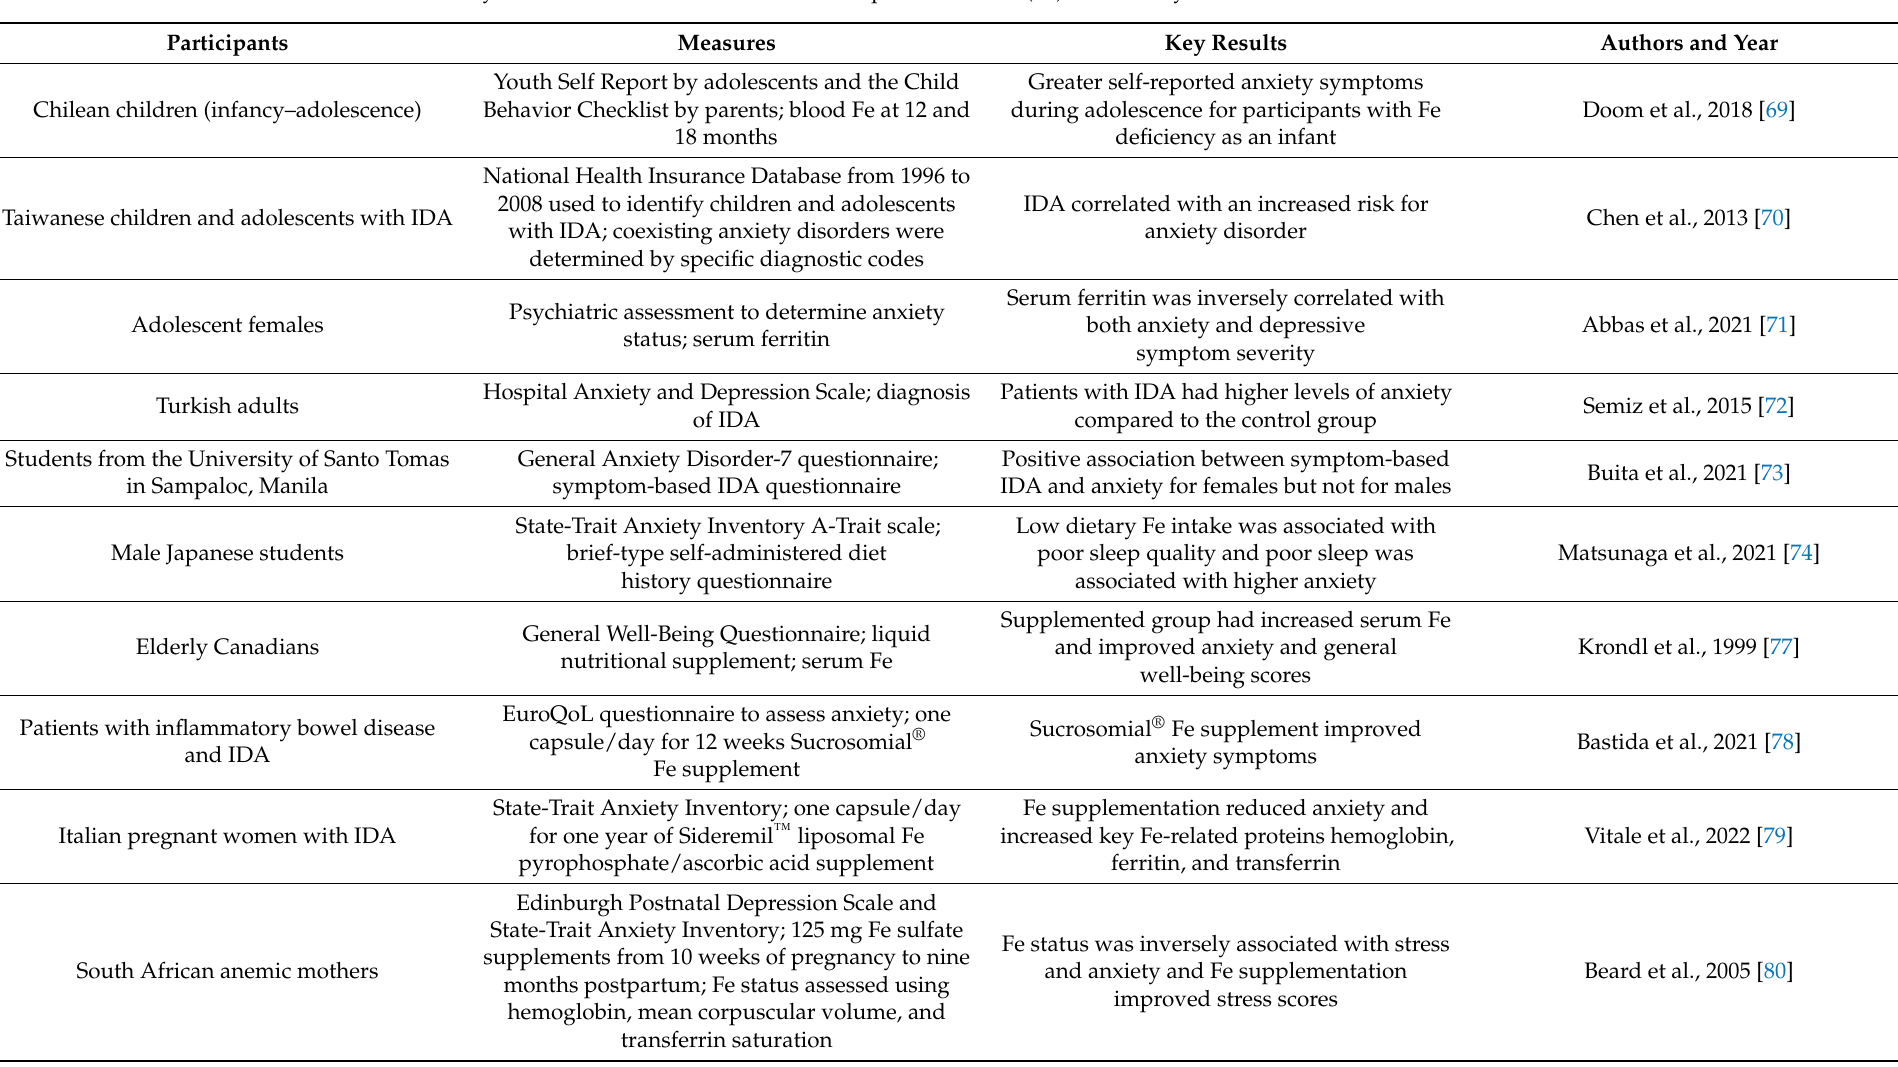
Table 3. Summary of clinical evidence for the relationship between iron (Fe) and